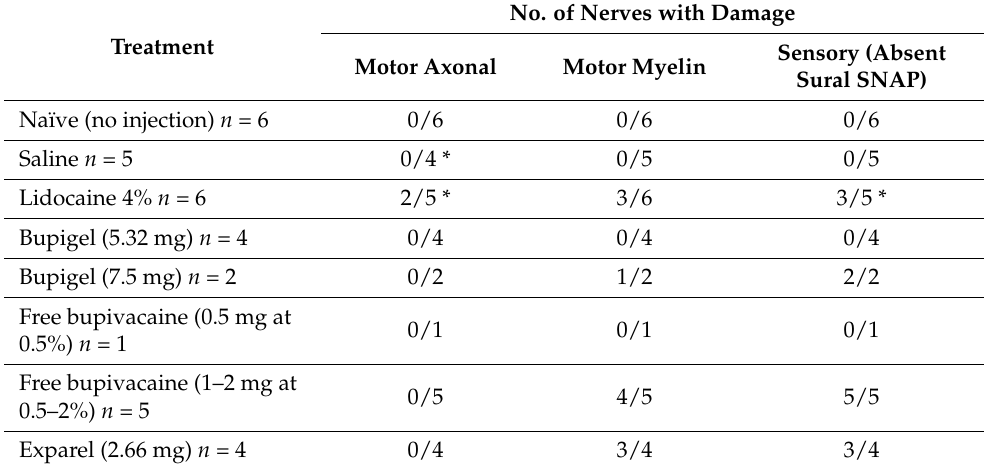
Table 3. Summary of signs of nerve damage according to